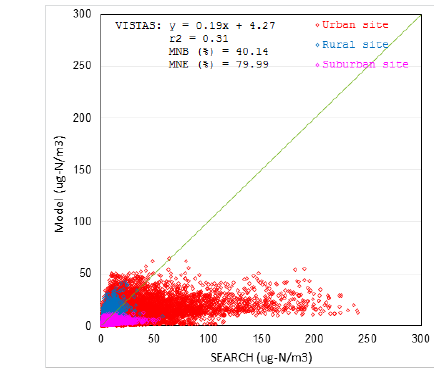
Figure 2. Scatter plots of ( a ) Annual average NO average NO concentrations: VISTAS 2002 annual Community Multiscale Air Quality Y (CMAQ) simulation vs . Southeastern Aerosol Research and Characterization (SEARCH) monitoring data.